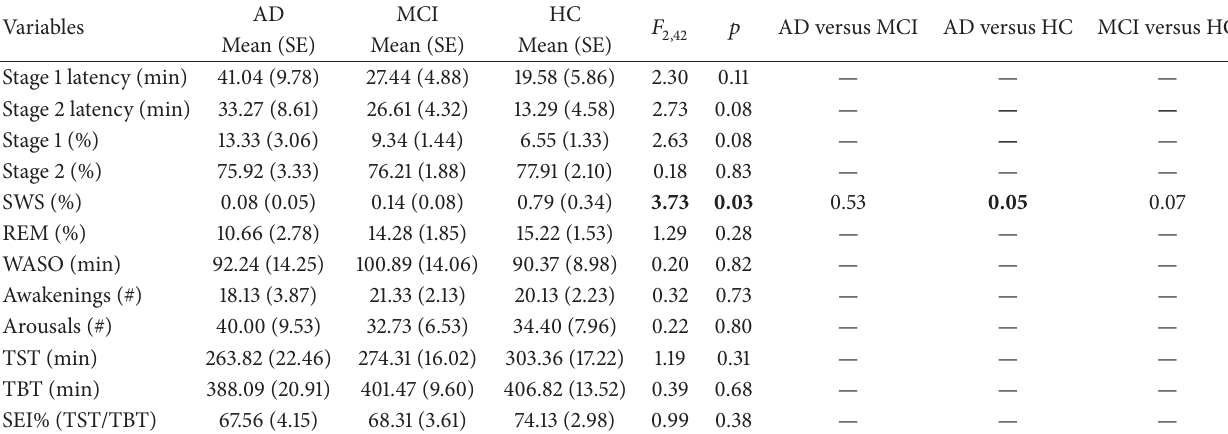
Table 2: Mean and standard errors of the polysomnographic variables of AD patients, amnesic MCI patients, and HC. The results of the one-way ANOVAs ( 𝐹 and 𝑝 values) were also reported, with post hoc unpaired 𝑡 -test ( 𝑝 values) when ANOVAs were significant ( 𝑝 ≤ 0.05 ). Significant between-groups differences are indicated in